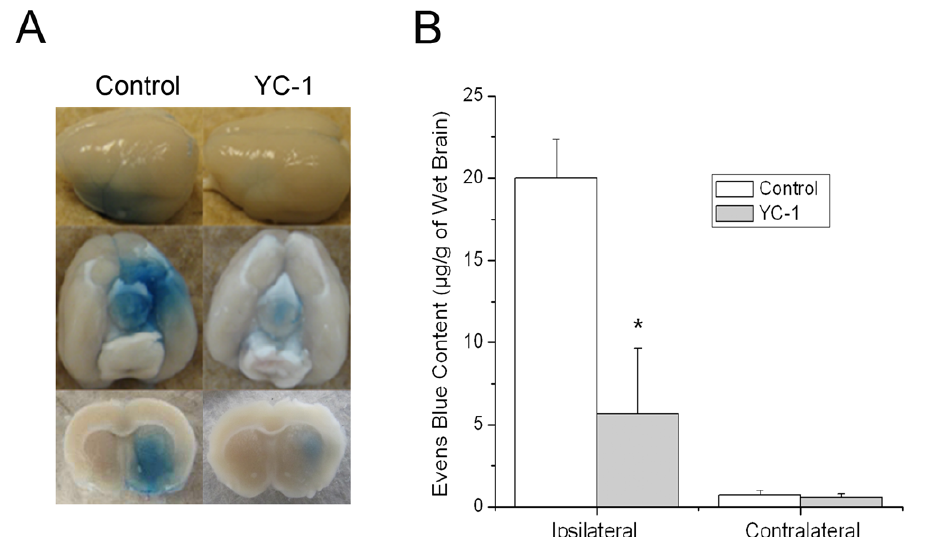
Figure 4. Effects of YC-1 on the BBB permeability of MCAO rats. BBB permeability was estimated by Evans blue leakage after rats were subjected to 90 min ischemia and 24 hr reperfusion. Animals received YC-1 (2 mg/kg, i.v.) at 24 h and 30 min prior to the onset of ischemia. ( A ) Representative images of Evans blue extravasation in a whole brain and coronal sections (bregma + 0.70 mm). ( B ) Quantification of Evens blue leakage in ipsilateral and contralateral hemispheres of MCAO rats (n=12 (control), 9 (YC-1)). Values are means 6 SEM. * p , 0.05 vs. control.